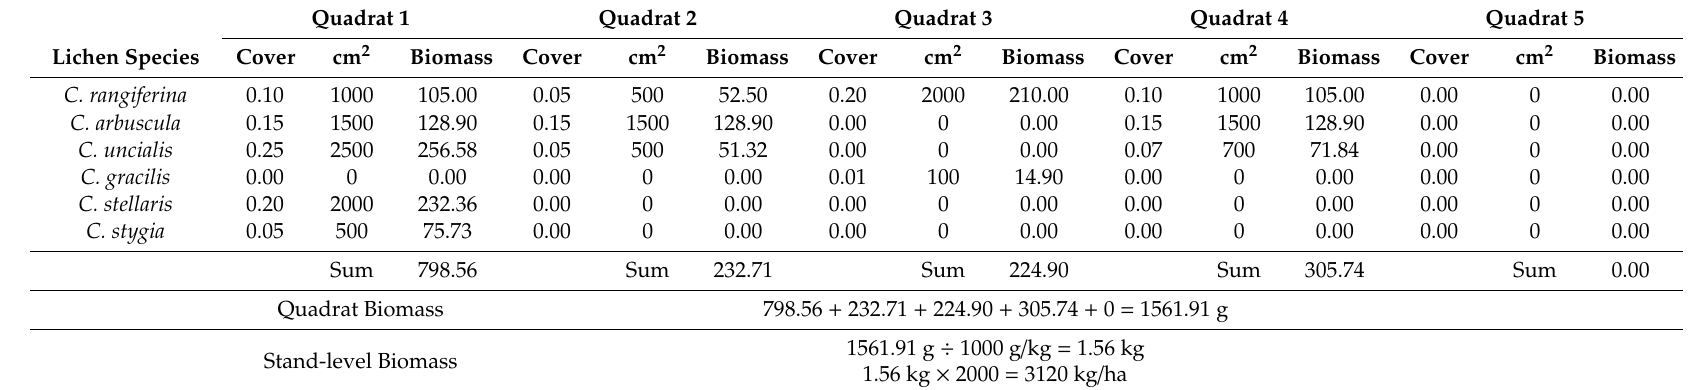
Table A2. Example calculation to derive a stand-level estimate of lichen biomass (kg / ha) for a sampling location using the protocol described in this paper. Species classification and conversion factors are adapted from McMullin et al. (2011)